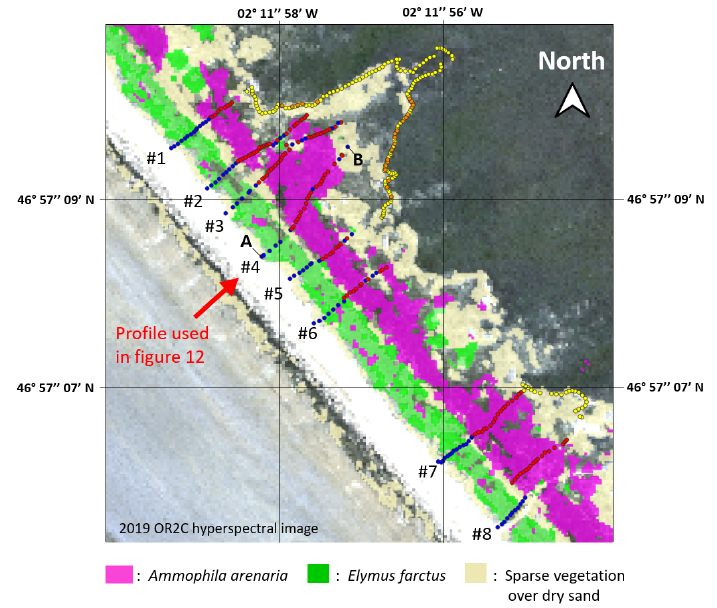
Figure 11. dGPS field measurements versus classified foredune proxies. The extension of the classes 3 to 7 is shown in magenta, containing Ammophila arenaria classified using the FWF argument; the extension of classes 20 to 24 is shown in green, containing Elymus farctus . Sparse vegetation over dry sand, which corresponds to class 17, is represented by light yellow. Yellow points represent dGPS points acquired over the white dune crest, and red points correspond to those sampled on Ammophila arenaria , making 8 different numerated profiles oriented perpendicularly to the coastline; blue points correspond to other dGPS points.